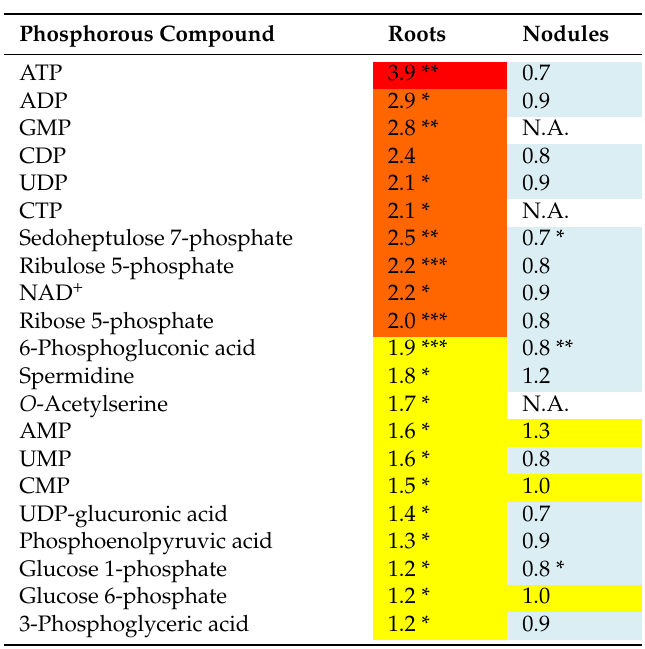
Table 2. Comparison of the ratios of concentrations of phosphorous compounds in soybean roots and nodules treated with 5 mM of nitrate for 24 h and the control